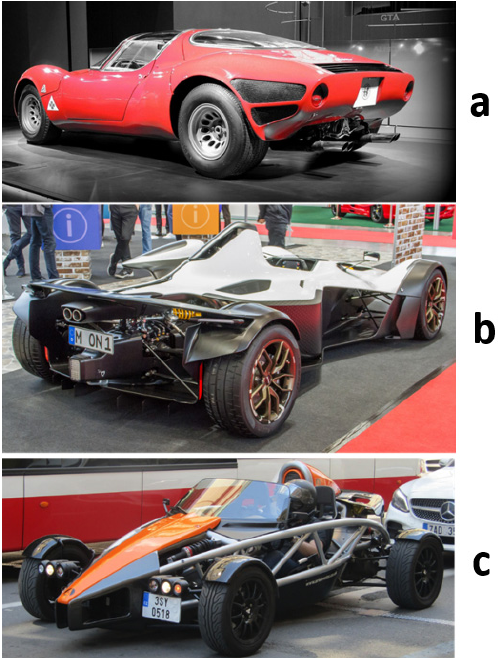
Figure 16. ( a ) Alfa Romeo 33 Stradale, ( b ) BAC Mono, ( c ) Ariel Atom.